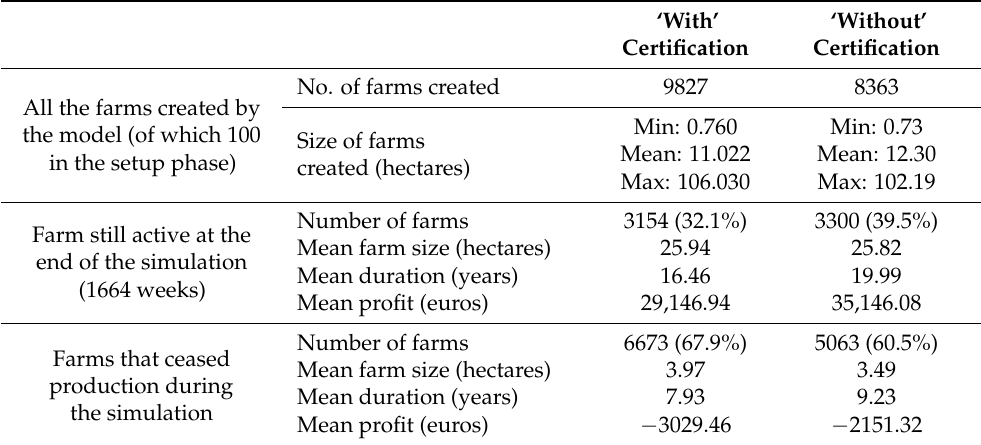
Table 4. Results of model operation. Comparison of ways ‘with’ and ‘without’ certification. Sum of the 50 repetitions of model